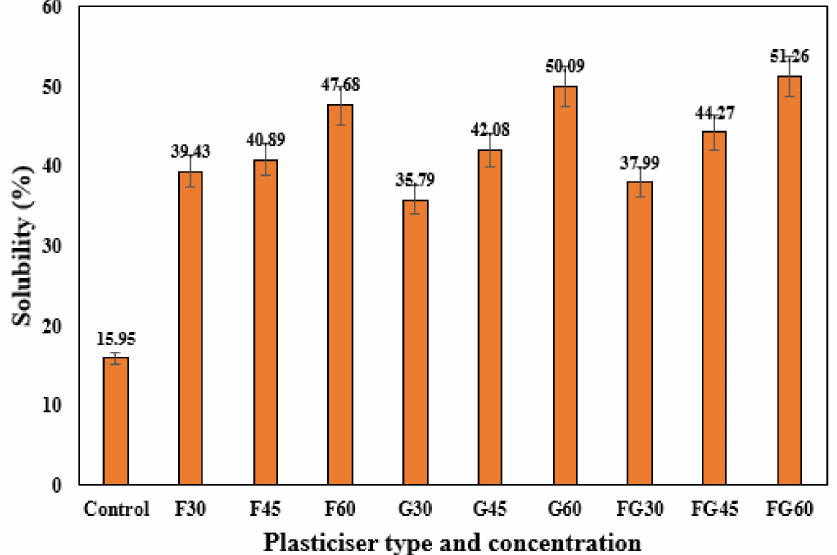
Figure 3. Solubility of corn starch films with various plasticizer types at different